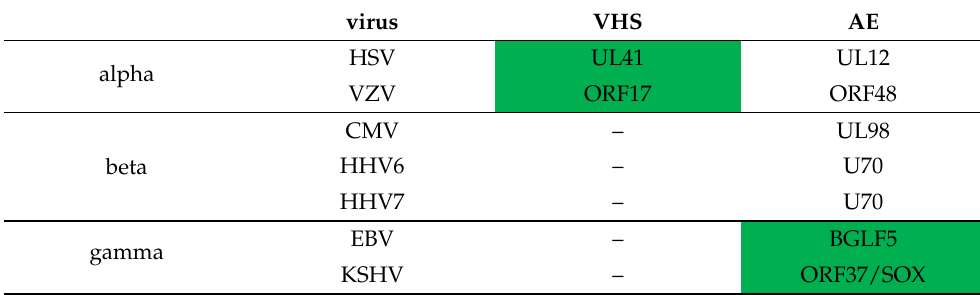
Table 1. Diverse herpesvirus genes mediate host shutoff. Virion host shutoff (vhs) protein homologs are found only in alphaherpesviruses. In gammaherpesviruses, host shutoff is mediated by the alkaline exonuclease (AE) proteins. Collectively, herpesvirus proteins that promote degradation of host mRNAs are referred to as host shutoff factors (HSF) and are shaded green. Note that host shutoff is not observed during betaherpesvirus replication.